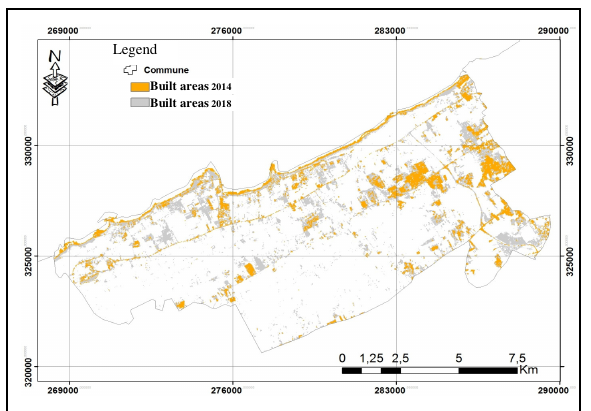
Figure 4 : results of the statistical analysis of household data for the calculation of travel